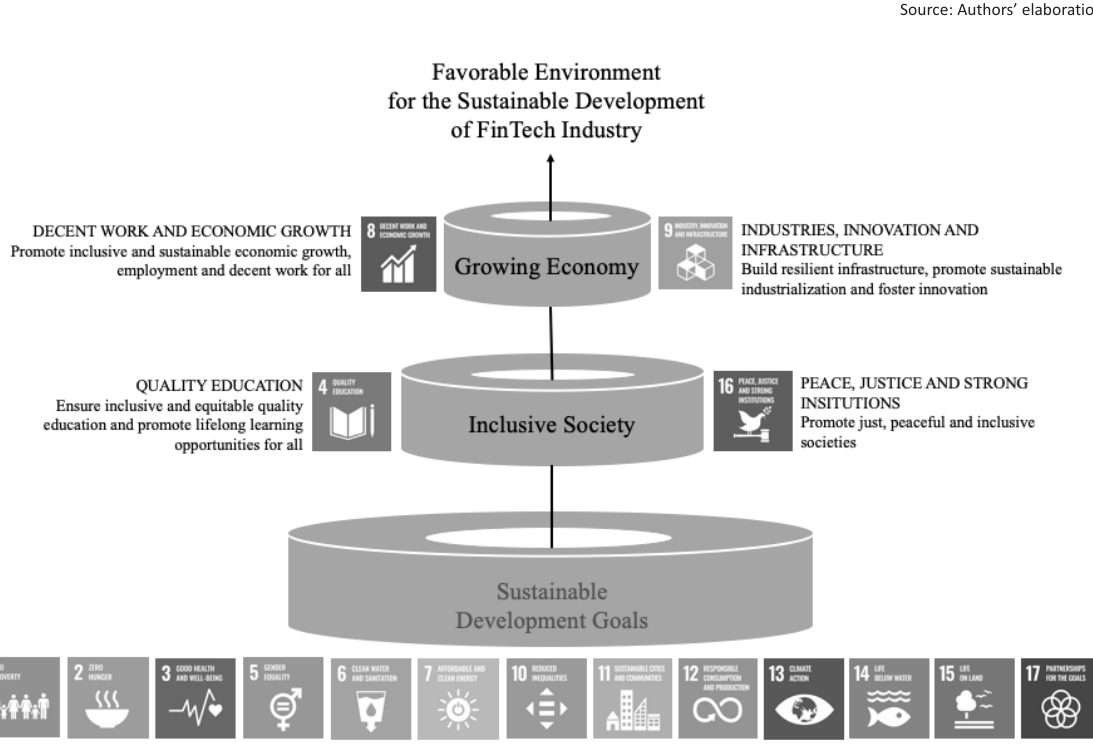
Figure 3. Link between Sustainable Finance model, SDGs, and PEST environment for the sustainable development of FinTech